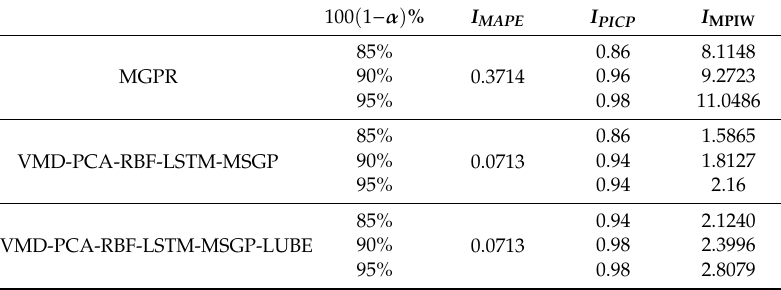
Figure 19. Interval prediction results of VMD-PRBF-LSTM-MGPR-LUBE. Table 3. Analysis table of interval forecast evaluation index.